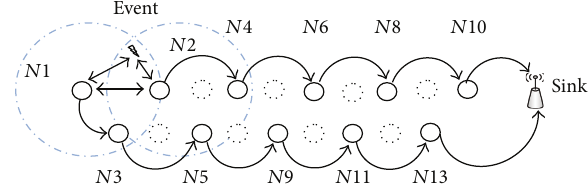
Figure 11: Event reporting scenario in WSNs with increasing deployment nodes.